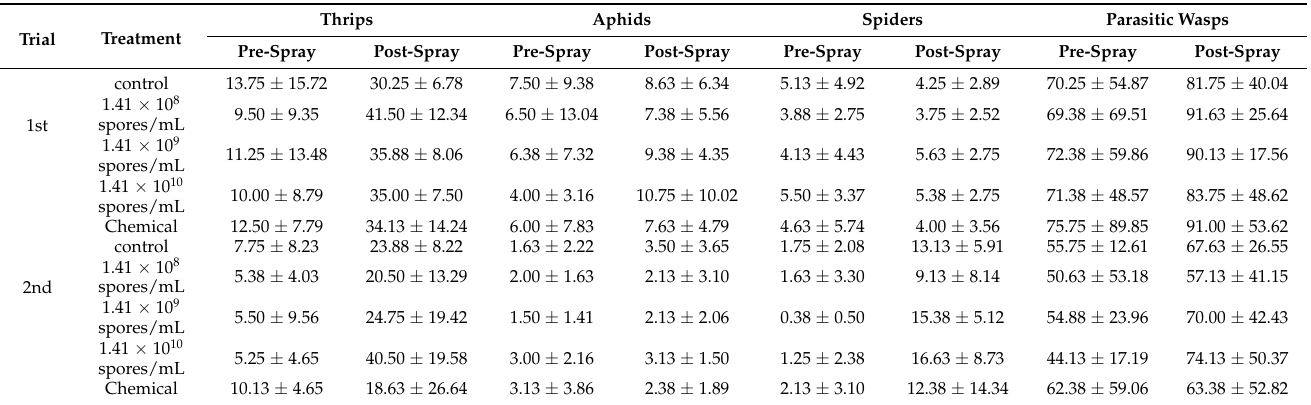
Table 6. Impact assessment of P. lilacinum TBRC 10638 and imidacloprid applications on the number of non-target insects (mean ± SE) during the first and second